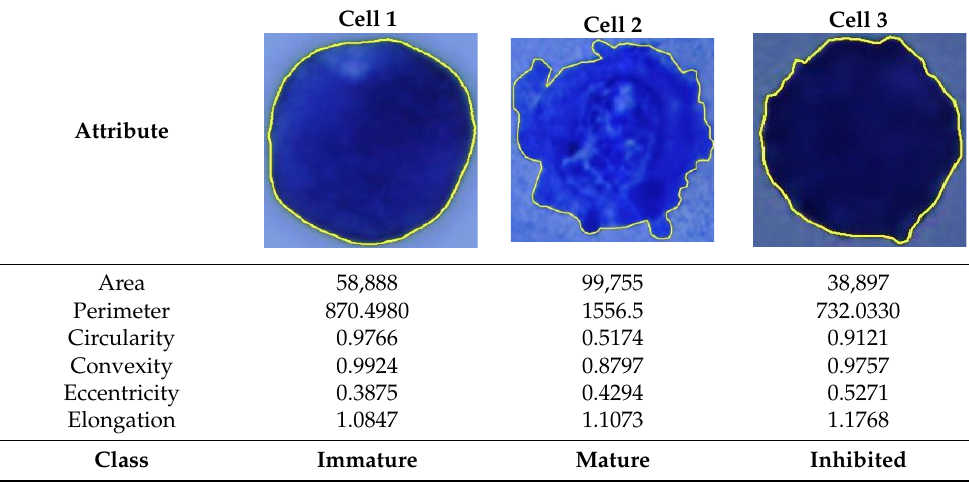
Table 3. Numerical values of the morphological characteristics of sample cells segmented and classified by the expert biologist.